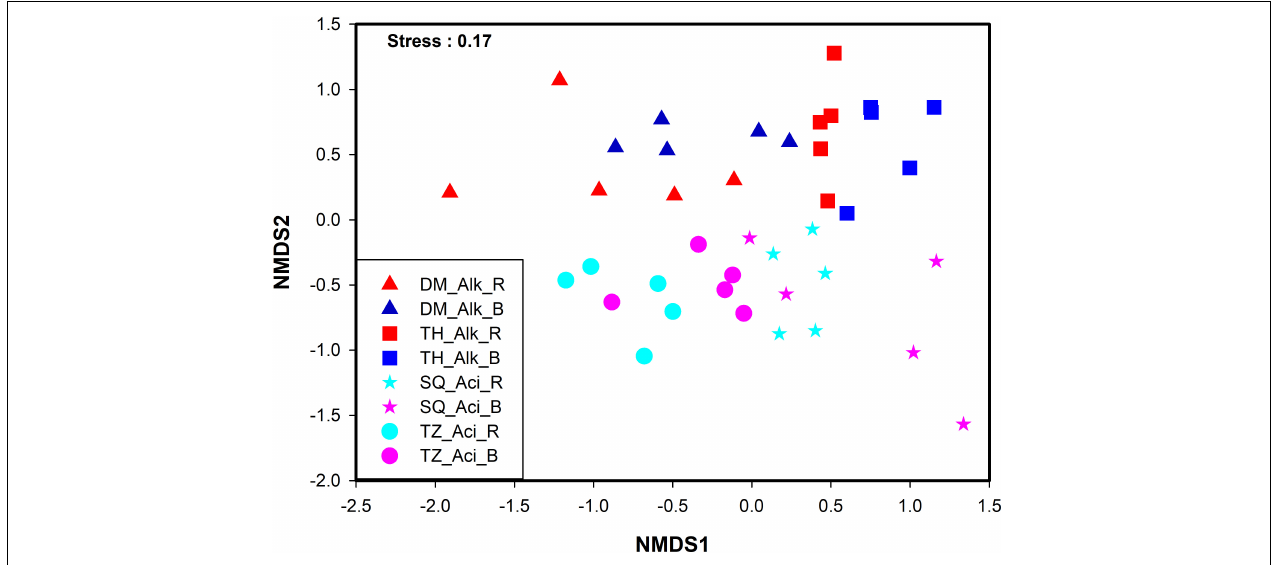
FIGURE 2 | Non-metric multidimensional scaling (NMDS) ordinations showing the microeukaryotic community compositional dissimilarities among the four sampling sites. Triangles, Daming [DM]; squares, Taihe [TH]; stars, Sheqi [SQ]; circles, Tengzhou [TZ]; red, alkaline rhizosphere soil; blue, alkaline bulk soil; light blue, acidic rhizosphere soil; pink, acidic bulk soil.